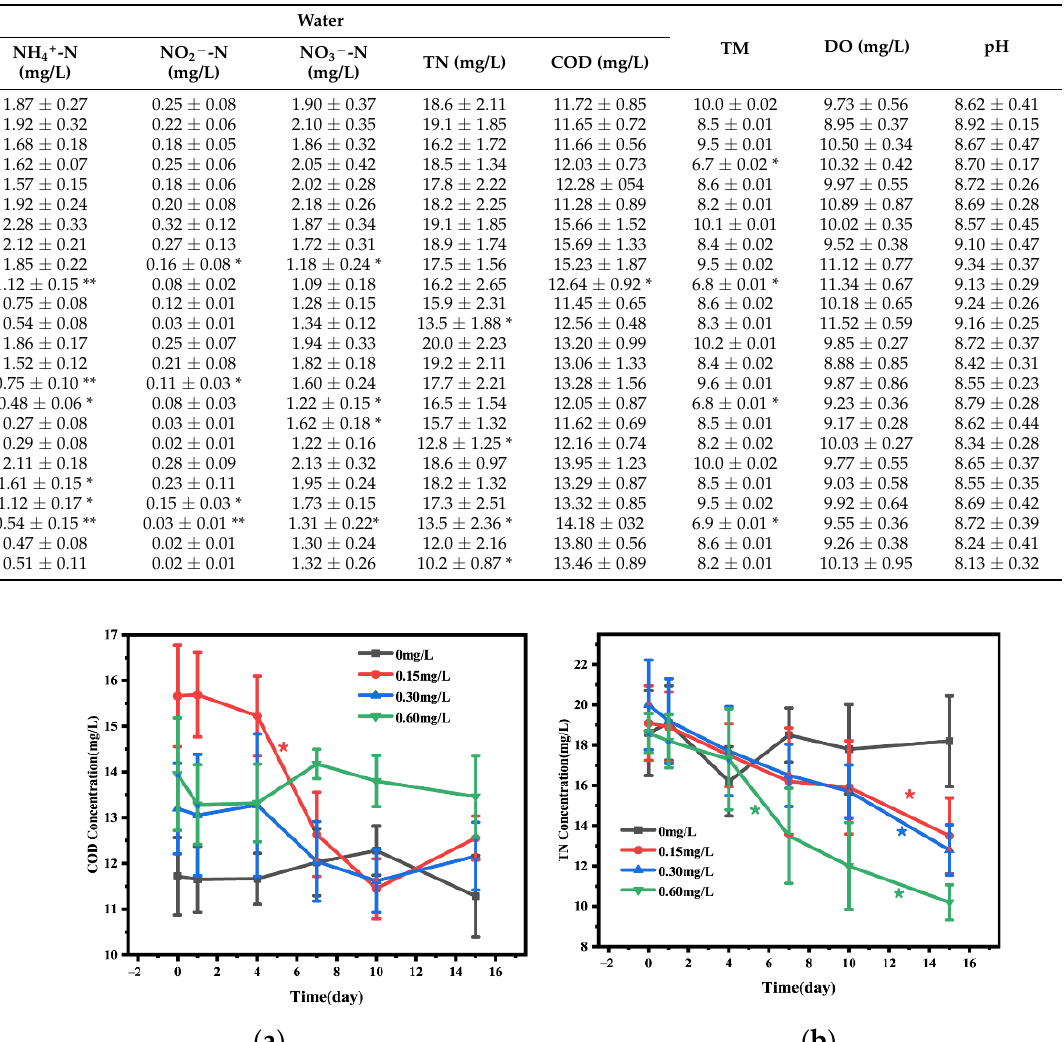
Figure 3. Concentrations of COD ( a ) and TN ( b ) in the water added with different concentrations of nitrifying and denitrifying bacteria. The black “*” indicate significant differences between 0 mg/L groups, the red “*” indicate significant differences between 0.15 mg/L groups, the blue “*” indicate significant differences between 0.30 mg/L groups, and the green “*” indicate significant differences between 0mg/L groups. (the “ * ” expression p < 0.05).